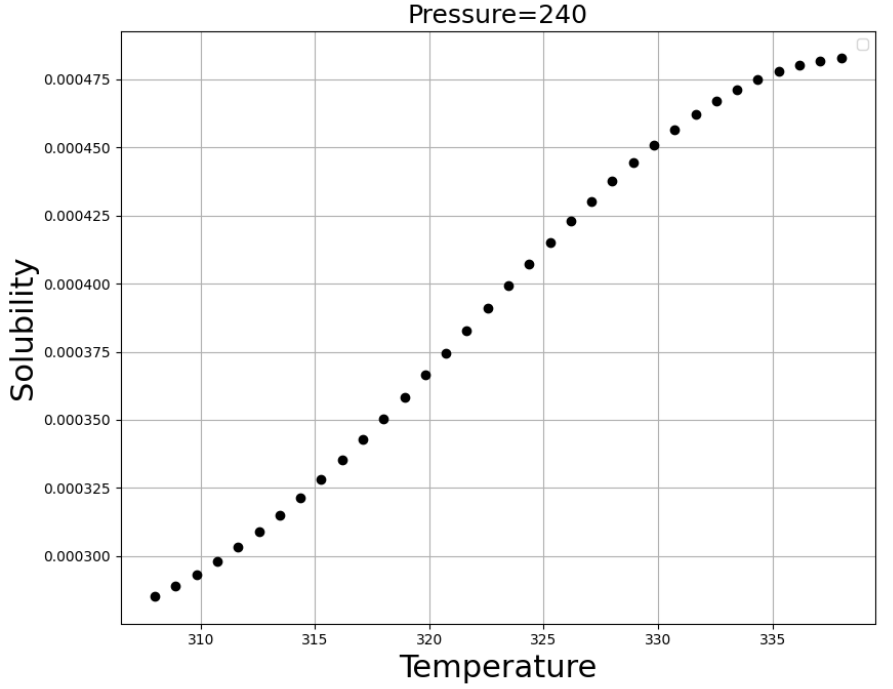
Figure 6. Trends for Temperature (K).